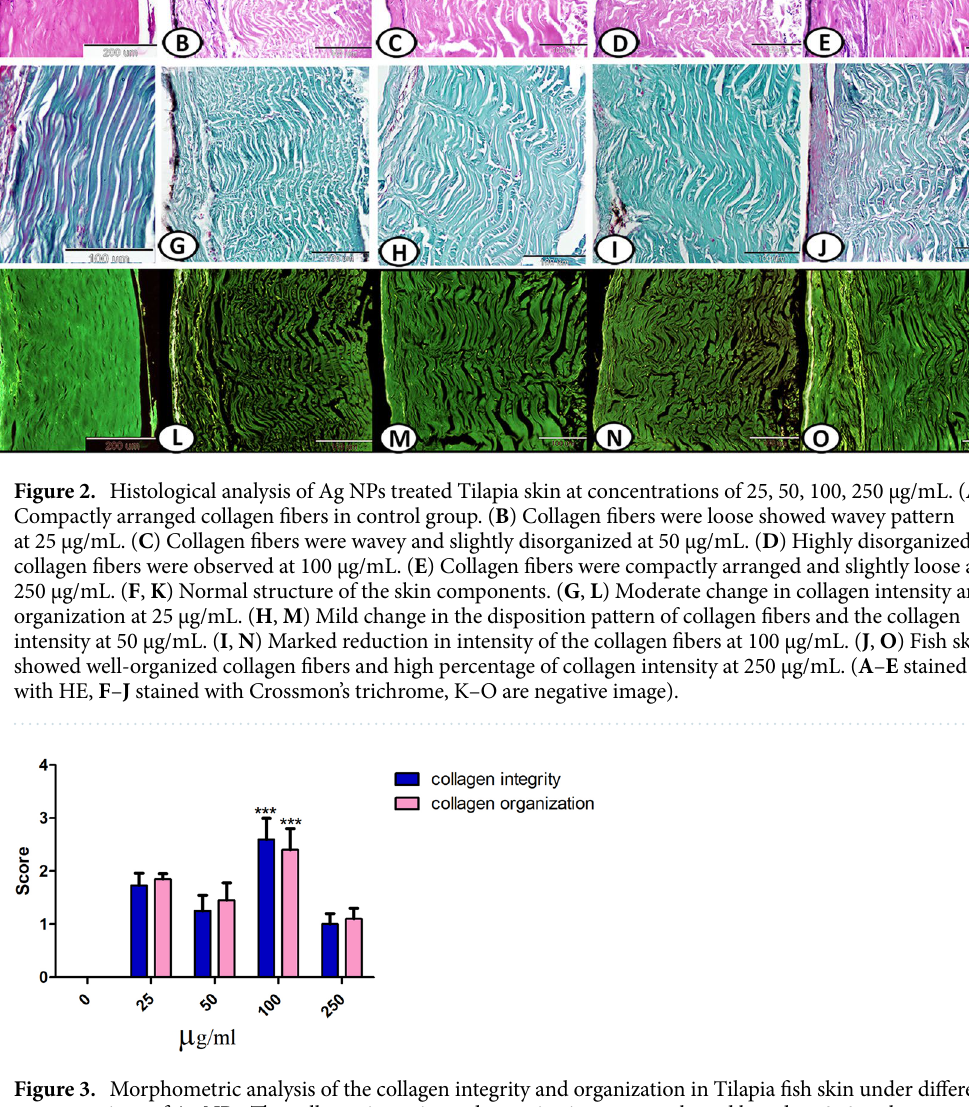
Figure 3. Morphometric analysis of the collagen integrity and organization in Tilapia fish skin under different concentrations of Ag NPs. The collagen integrity and organization were evaluated based on 0–3 scale as previously mentioned in the materials and methods. *** p < 0.0001